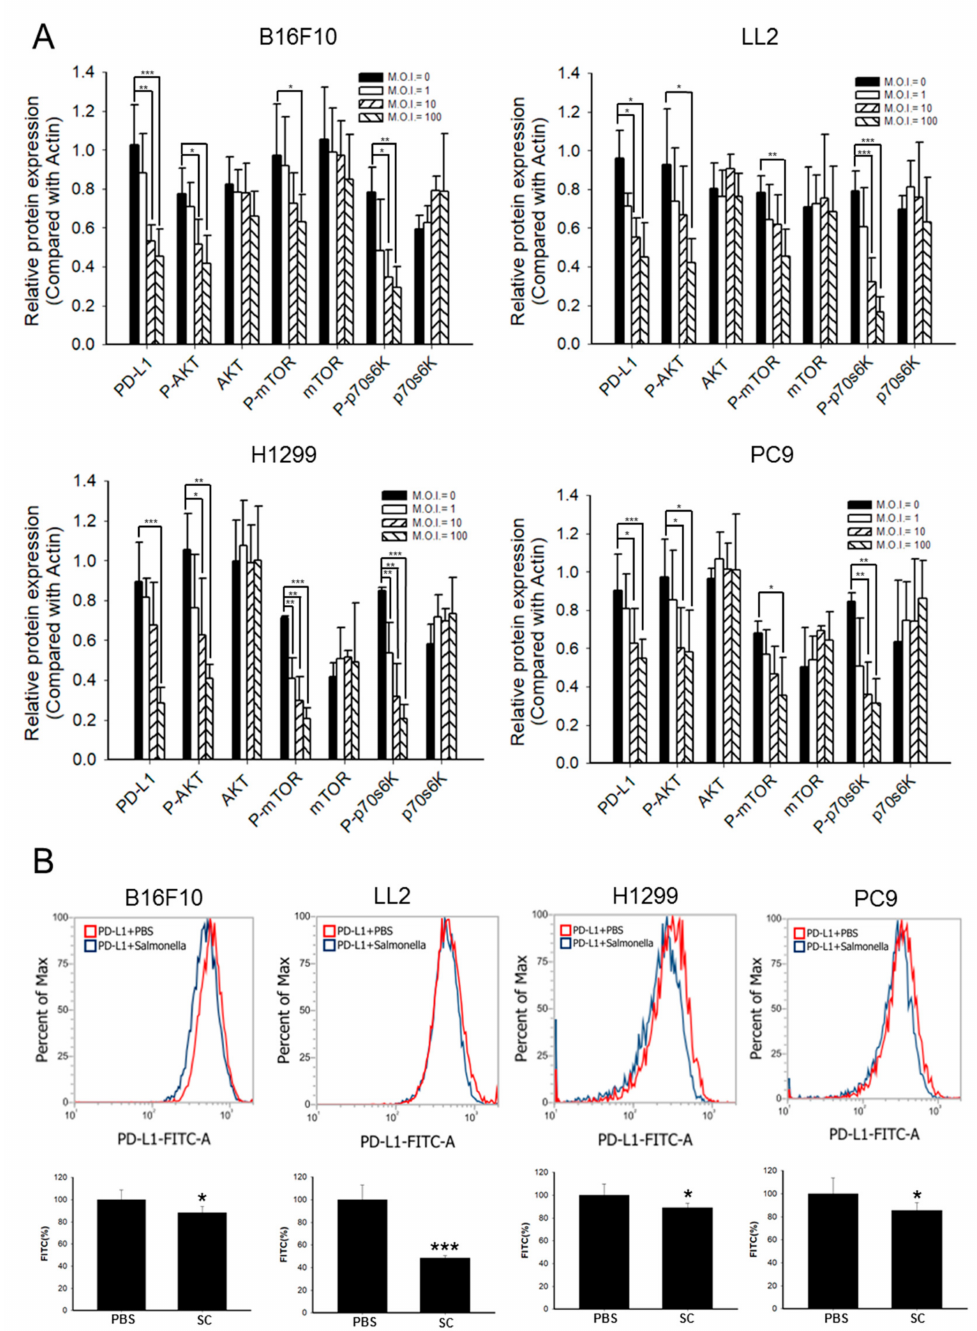
Figure 2. Salmonella (S.C.) reduced the expression of programmed death-ligand 1 (PD-L1. Cancer cells were seeded in 6-well plates. Afterwards, cells were treated with di ff erent doses (multiplicity of infection (M.O.I.) = 0, 1, 10, and 100) of Salmonella for 90 min and cultured in free Dulbecco’s Modified Eagle Medium (DMEM) with 1% Gentamicin for 24 h. ( A ) Quantified band intensities of respective proteins in Salmonella -infected cell lines. B16F10, LL2, H1299, and PC9 cells were lysed and their PD-L1 and protein kinase B (AKT) / mammalian targets of rapamycin (mTOR) / p70 ribosomal s6 kinase (p70s6K) markers were examined by Western blotting (please see Supplementary Figure S2). ( B ) Cells were treated with 100 M.O.I. Salmonella for 90 min and PD-L1 expression analysis on tumor cells by flow cytometry was performed after fixing cells in 70% ethanol at − 30 ◦ C overnight; the bar graph also shows the quantified value of PD-L1-FITC-A. *, p < 0.05; **, p < 0.01; ***, p <